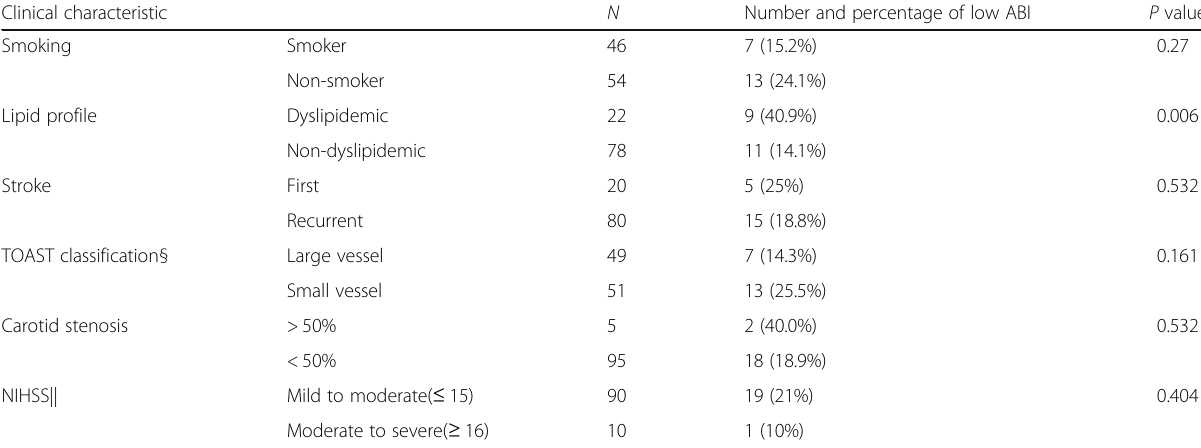
Table 4 Relation between abnormal ABI and some risk factors and clinical characteristics of stroke in patients ’ group Clinical